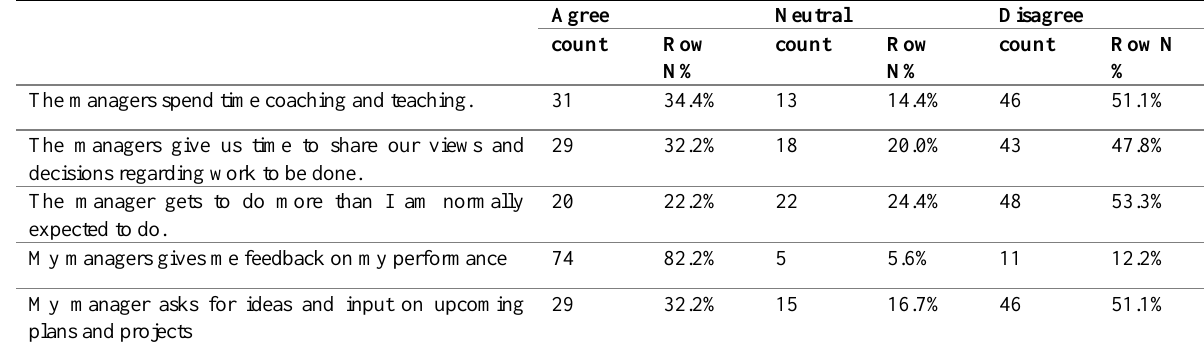
Table 2: frequency distribution the transformational leadership style